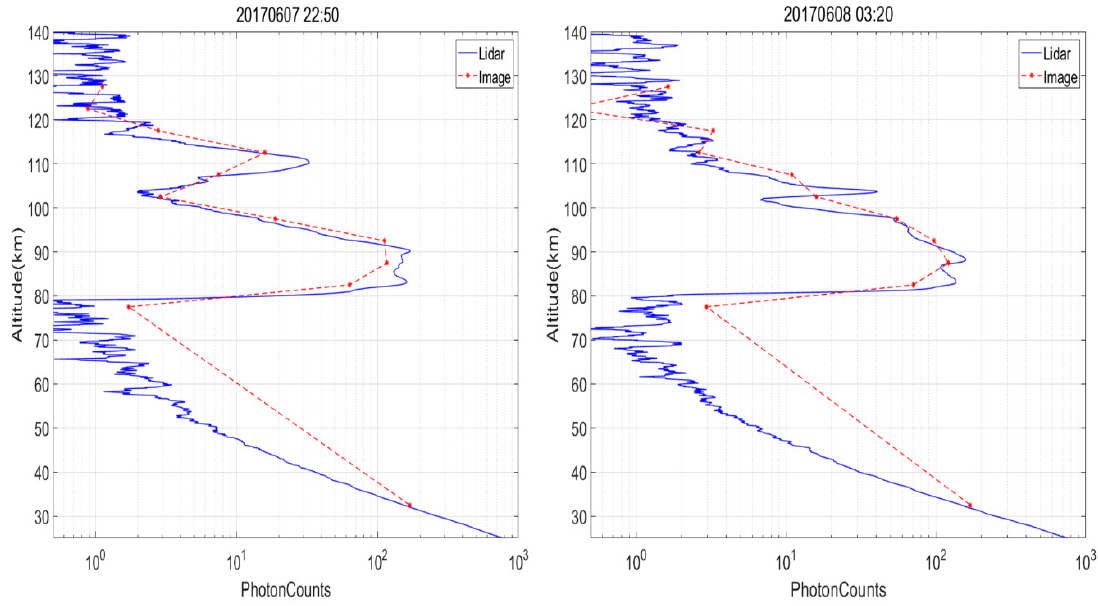
Figure 6. The photon counting profiles derived from the Na lidar measurements (blue solid-line) and the Na fluorescence intensity profiles measured simultaneously by the collocated multilayer Na imager (red dashed-line).